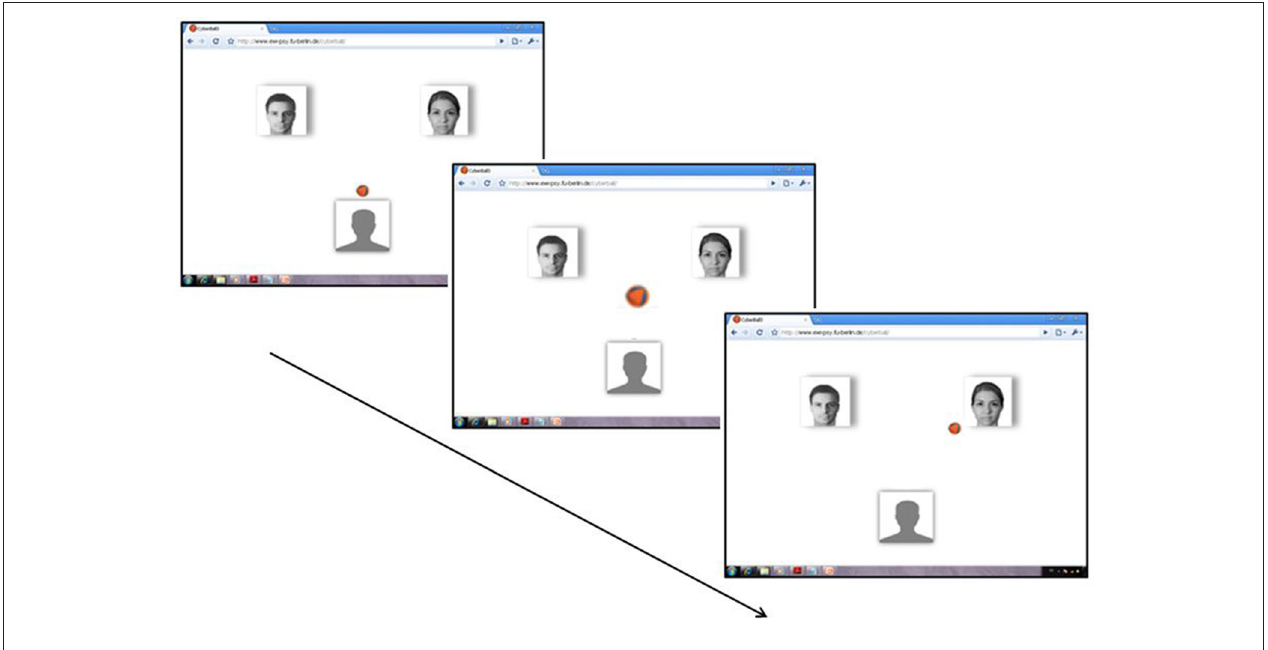
co-player. Ball possession of a co-player followed a computer-generated random time interval varying from 400–1.400 ms. The photographs of co-players depicted—and used in the experiment for all participants—refer to morphs of portraits taken from different persons. (For the setup of the screen: see Weschke and Niedeggen,